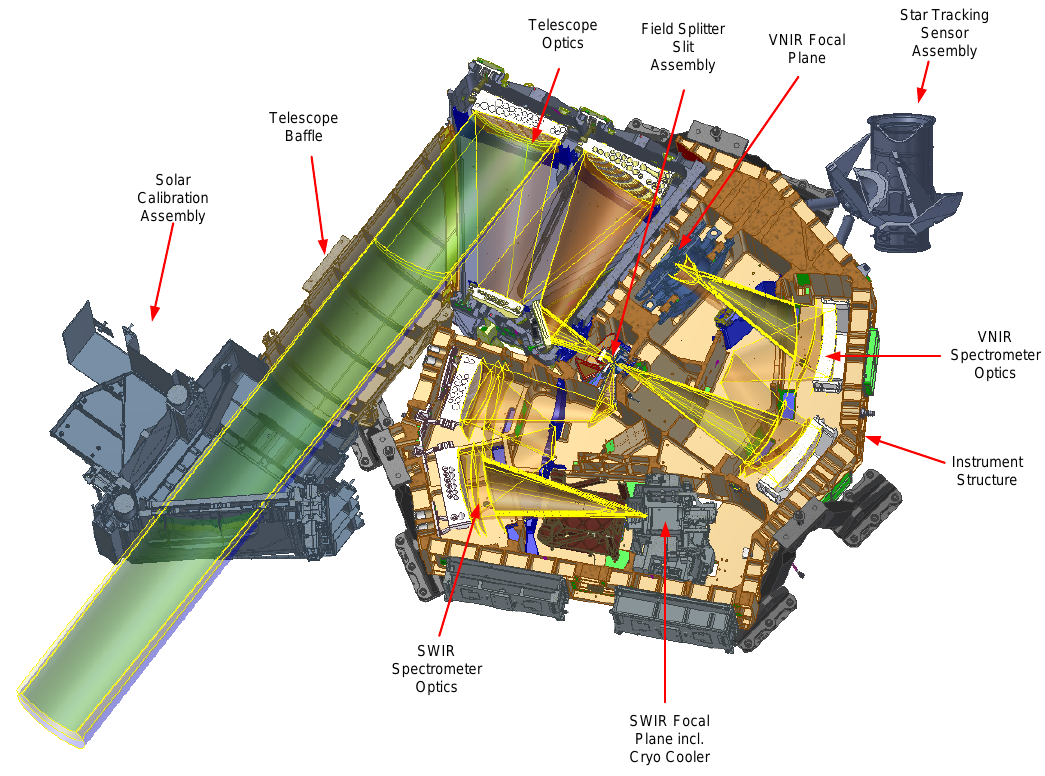
Figure 2. Schematic view of the main components of the EnMAP double-spectrometer instrument